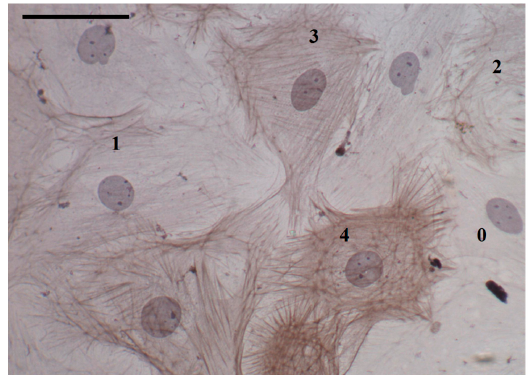
Figure 2. Cultured rat cardiac fibroblasts and myofibroblasts: characterization by α -smooth muscle actin ( α -SMA) staining and stress fiber formation. Fibroblasts (0) were characterized by an absence of α -SMA staining, having no stress fibers. Both fully mature and immature myofibroblasts expressed α -SMA stress fibers, with the rating (1–4) reflecting the degree to which stress fibers filled the cell. Scale bar = 50 μ m; magnification = 400×.